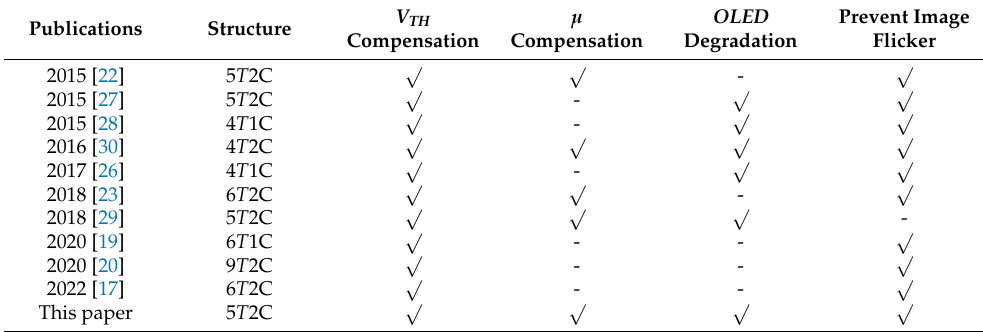
Table 2. Comparison between this paper and the previous publications.